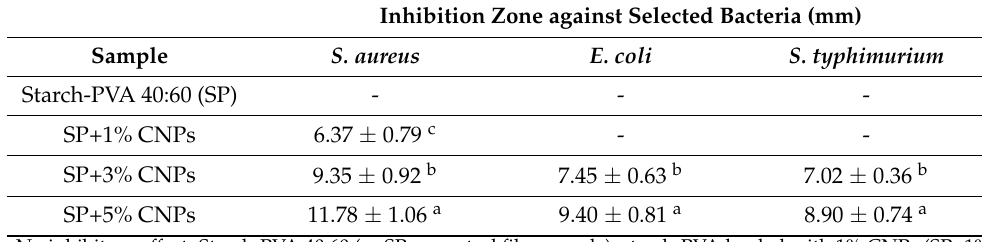
Figure 5. Pictures of the inhibition zones revealed in the case of agar diffusion test against S. aureus , E. coli and S. typhimurium . Starch-PVA 40:60 (or SP as control film sample), starch-PVA loaded with 1% CNPs (SP+1% CNPs), starch-PVA film loaded with 3% CNPs (SP+3% CNPs), and starch-PVA film loaded with 5% CNPs (SP+5% CNPs). Table 3. Antibacterial properties of starch-PVA-based